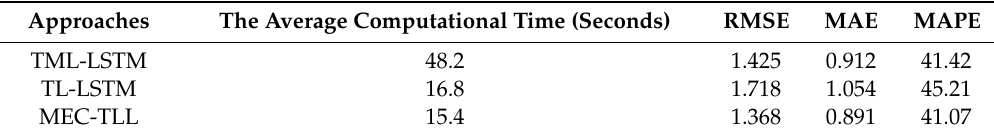
Table 2. Performance results of the experimental methods on the B2 dataset.